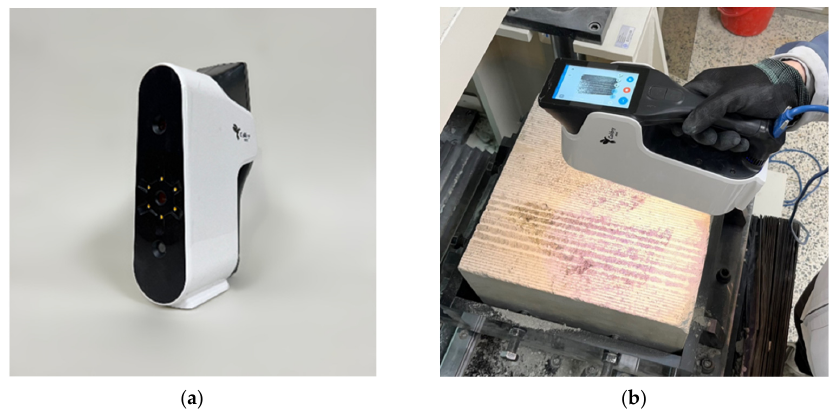
Figure 4. 3D scanning for volume measurement: ( a ) Calibry Mini and ( b ) example of 3D scanning.